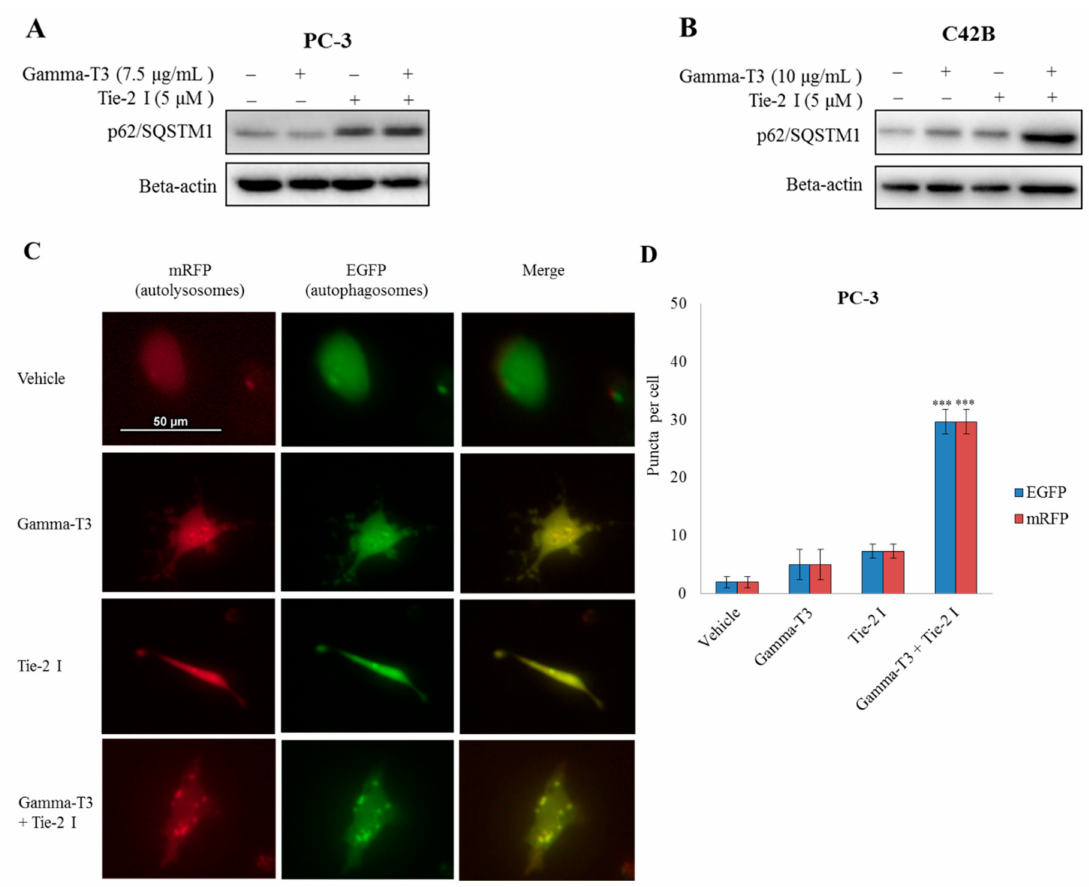
Figure 5. Inhibitory effect of Tie-2 inhibitor and γ -T3 on autophagic flux. Protein expression of p62 in PC-3 ( A ) and C42B ( B ) cells after treating with different combinations of Tie-2 inhibitor and γ -T3 was examined by Western blotting (representative Western blots are shown). ( C ) Measurement of autophagic flux using tandem fluorescent-tagged LC3: PC-3 cells transfected with fluorescent-tagged LC3 (mRFP-EGFP-LC3) before being treated with Tie-2 inhibitor/ γ -T3 or both compounds for another 72 h (40 × objective). Representative fluorescent images are shown. Red fluorescence signal represents autolysosomes (mRFP), while the green fluorescence signal represents autophagosomes (EGFP). Yellow fluorescence signal represented the merger of both mRFP and EGFP. ( D ) Cells with more than 5 puncta were quantified and at least 50 cells were counted in each group. Each experiment was repeated at least three times, and the results are presented as the mean ± SD. ( p values: *** < 0.0005). Scale bars, 50 µ